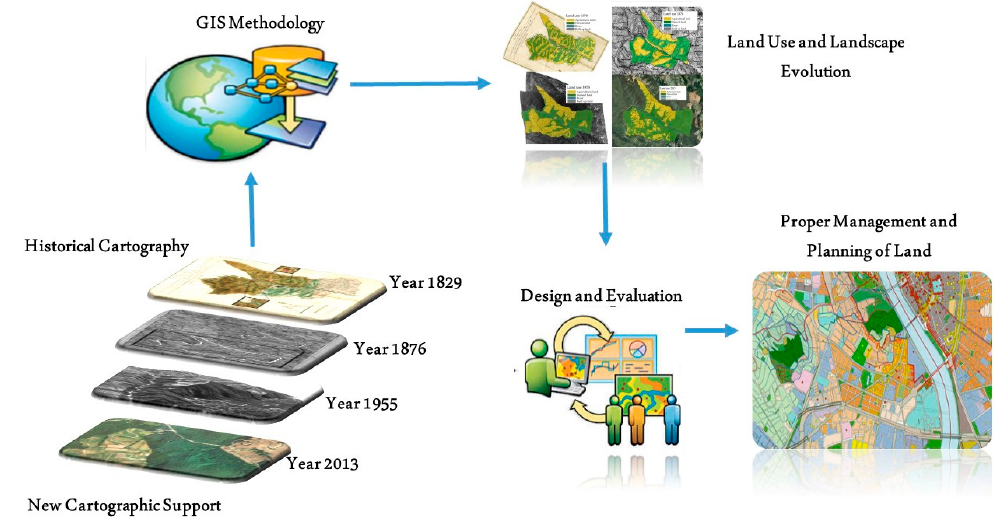
Figure 4. Applied Figure 4. Applied methodology.